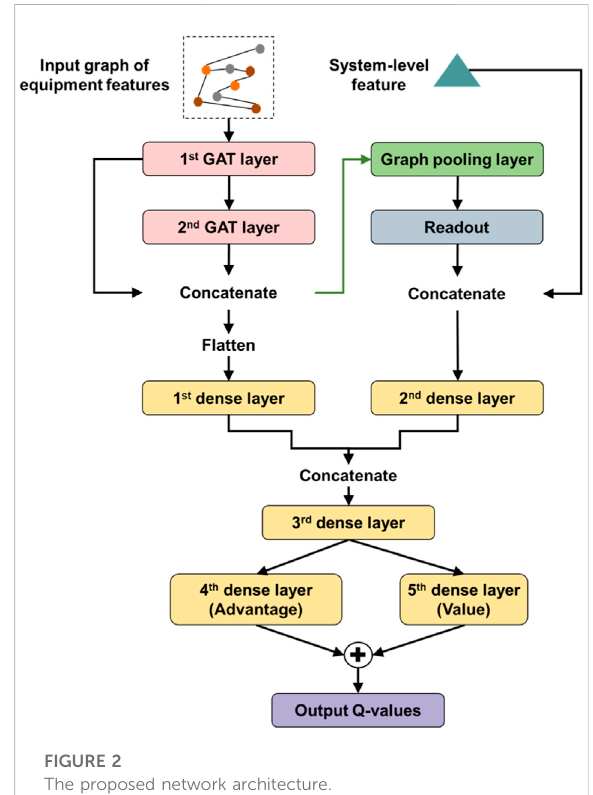
FIGURE 2 The proposed network